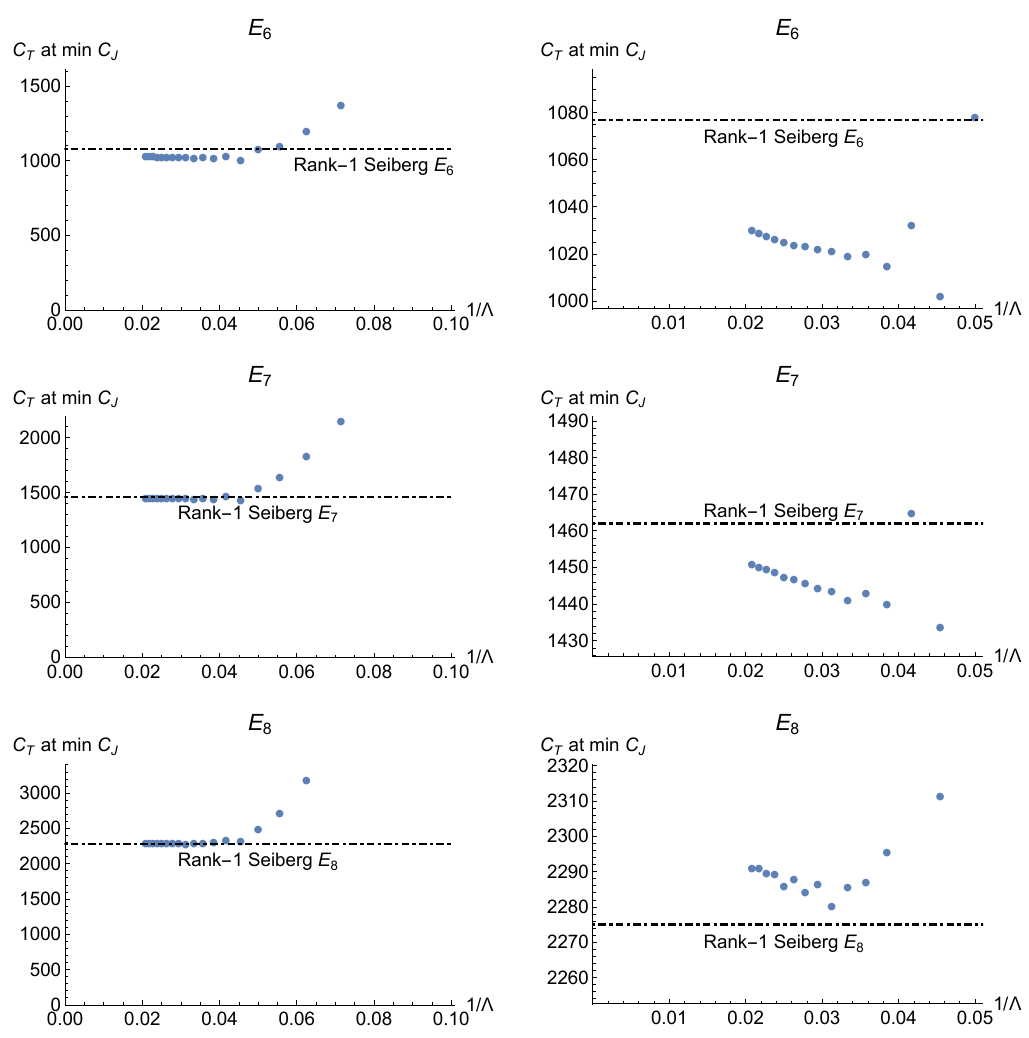
Figure 10. Left: the values of C J when the lower bounds on C T are saturated for interacting theories with E 6 , E 7 , and E 8 (cid:13)avor groups, at various derivative orders (cid:3). Also shown are the values of C T and C J in the rank-one Seiberg exceptional theories (dotdashed). Right: zoomed-in plots.